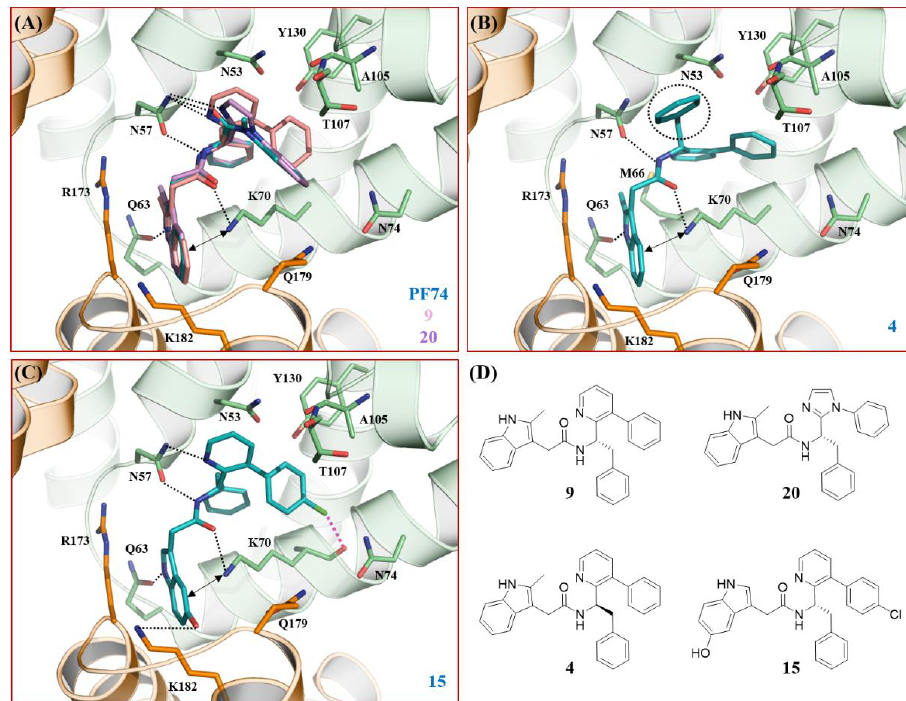
Figure 4. Docking poses of key ligands based on native HIV-1 capsid protein bound to PF74 (PDB code: 4XFZ [17]). ( A ) Superimposition of PF74 and compounds 9 and 20 depicting binding similarity to PF74 and the fitting of compounds 9 and 20 within the PF74 binding pocket. Glide scores (kcal/mol): − 5.6 (PF74); − 6.1 ( 9 ); − 5.3 ( 20 ); ( B ) predicted binding mode of 4 in which the benzyl group (circled) of the phenylalanine fragment points away from the hydrophobic pocket around residue M66. Glide score (kcal/mol): − 3.7; ( C ) predicted binding of analog 15 within the preferred PF74 binding cavity showing additional H- and halogen-bonding with K182 and K70, respectively. Glide score (kcal/mol): − 7.7; ( D ) chemical structures of compounds 4 , 9 , 15 and 20 . H-bond, halogen-bond and cation- π interactions are depicted as black dotted lines, pink dotted line and double headed arrow, respectively. CA NTD around H3 and H4, and CA CTD around H8 and H9 are colored green and orange, respectively. The nitrogen, oxygen, sulfur, and chlorine atoms are colored blue, red, yellow, and green,